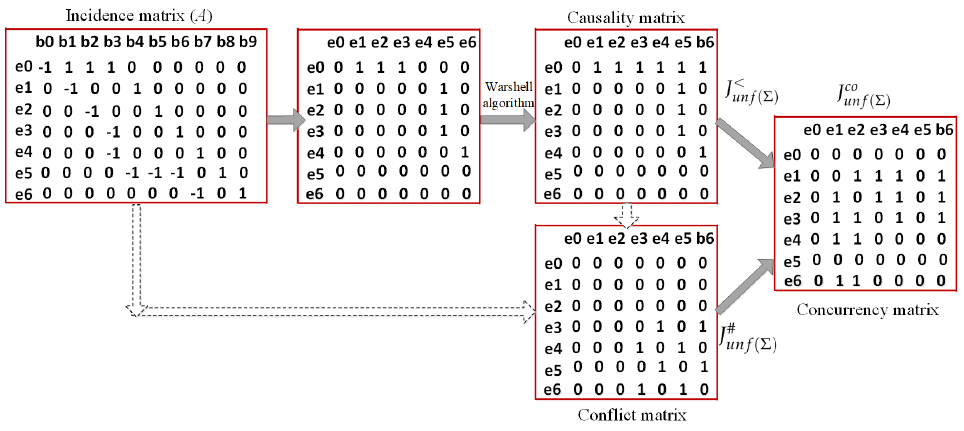
Figure 3. Some matrix manipulations on the FCP in Figure